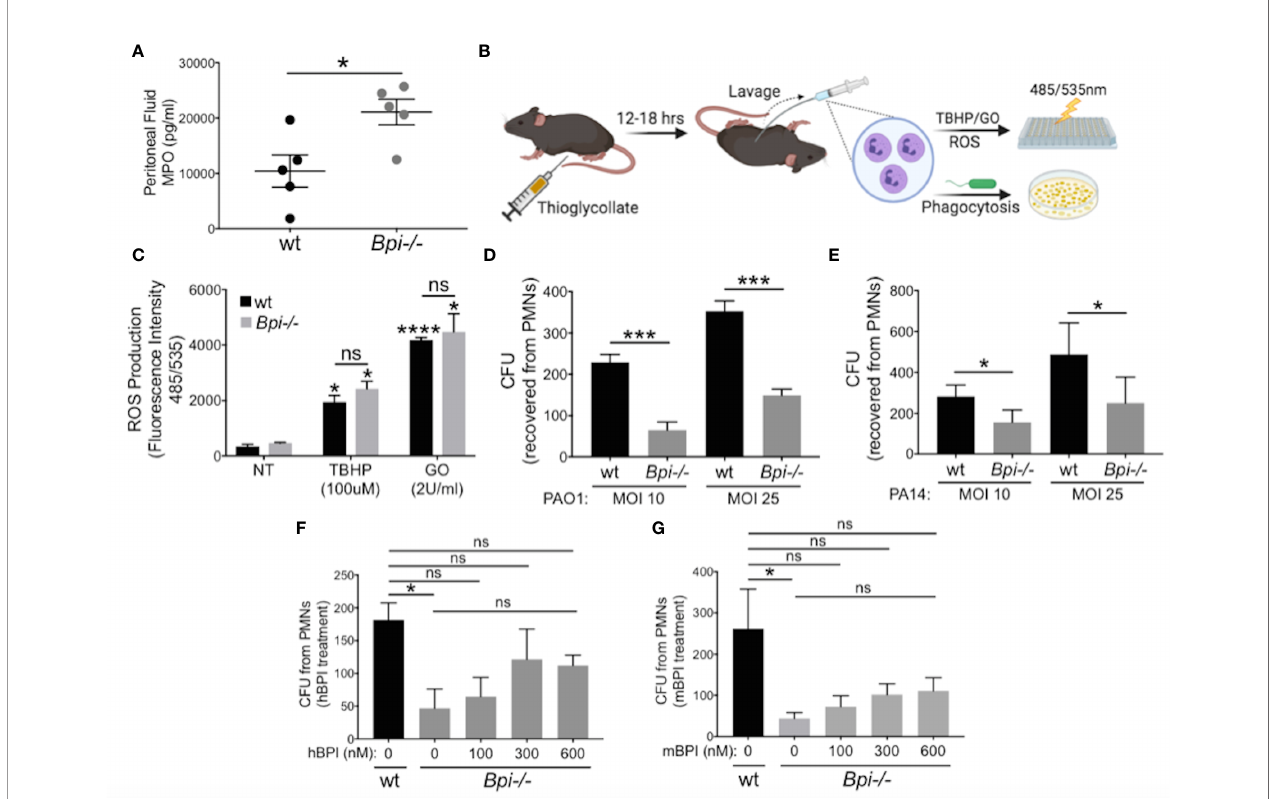
FIGURE 3 | BPI is required for P. aeruginosa phagocytosis but not neutrophils degranulation or ROS production. (A) Myeloperoxidase (MPO) concentration, measured by ELISA, in peritoneal fl uid of wild type (wt) and Bpi-/- mice (n=5) infected with PA14 (3hpi). Data were analyzed by unpaired t-test with Welch ’ s correction. (B) Mice were injected intraperitoneally with 1ml 4% thioglycollate, and neutrophils were harvested 12-18 hrs later for reactive oxygen species (ROS) or phagocytosis experiments. (C) ROS production of wt and Bpi-/- PMNs (n=3) after stimulation with tert-Butyl hydroperoxide (TBHP, 100 m M) or glucose oxidase (GO, 2U/ml) for 4hrs. Statistical signi fi cance was determined relative to untreated (NT) cells (*p < 0.05) or between genotypes (ns, not signi fi cant). (D, E) Intracellular colony-forming unit (CFU) counts obtained from lysed wt and Bpi-/- mouse PMNs (mPMNs) challenged with P. aeruginosa (D) PAO1 (n=4) and (E) PA14 (n=3) at multiplicity of infection (MOI) of 10 and 25; Statistical signi fi cance was determined by paired Student t-test; (F, G) Intracellular CFU counts from wt and Bpi-/- mPMNs treated with P. aeruginosa PAO1 (MOI 25, n=3) with increasing concentrations of (F) native human BPI (hBPI, 0-600 nM) or (G) recombinant mouse BPI (mBPI, 0-600 nM). Statistical signi fi cance was determined by one-way ANOVA with multiple comparisons for (C) , and unpaired t-test with Welch ’ s correction for others. ****p < 0.0001, ***p < 0.001, *p < 0.05, ns, not signi fi cant; Error bars represent mean ±